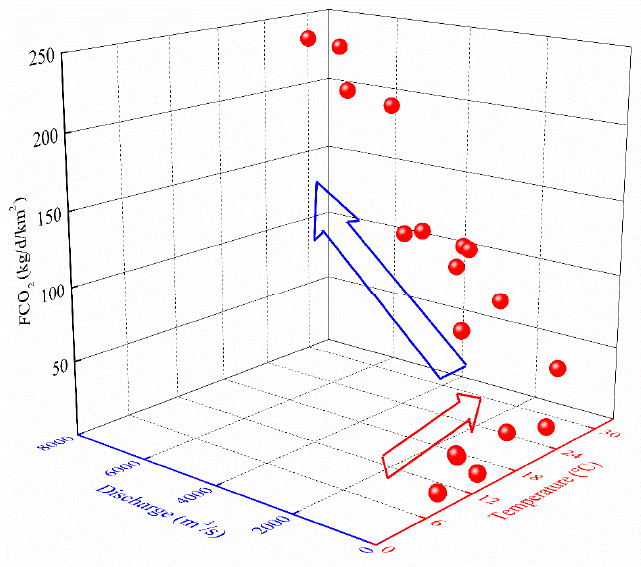
Figure 8. Three-dimensional representation of F CO 2 , discharge, and temperature for the Liujiang River in a hydrological year.